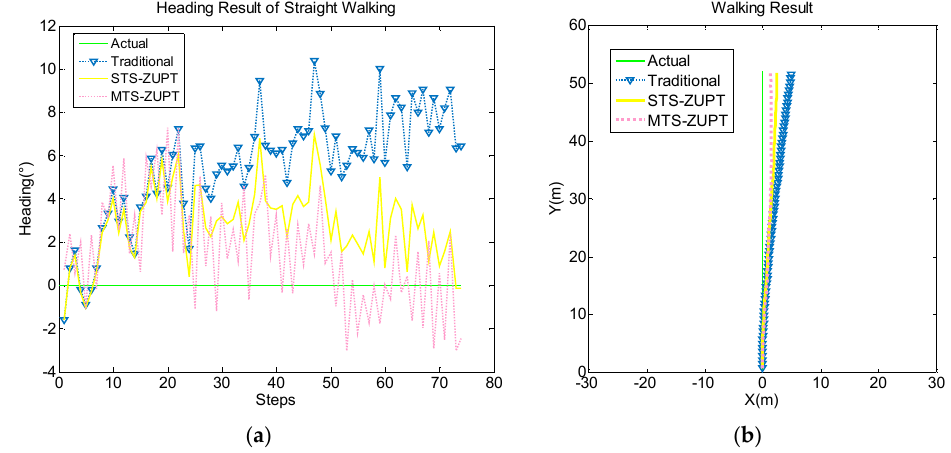
Figure 8. Straight Walking Result Comparison of MTS-ZUPT and STS-ZUPT. ( a ) Heading result; ( b ) Route result.